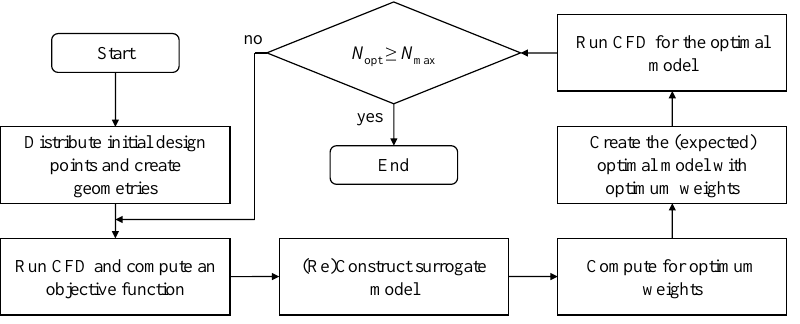
Figure 14. Flow chart of the iterative optimization process.